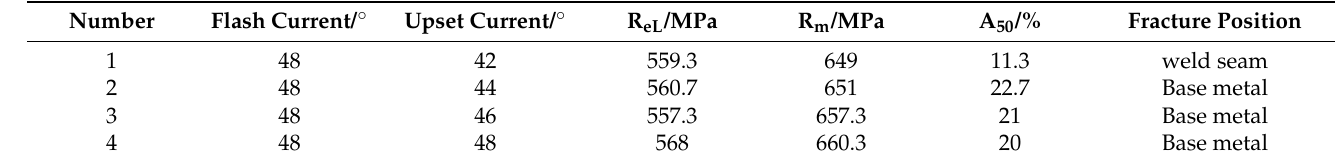
which is 284.9 HV. According to the results of joint hardness distribution under different upsetting currents, the optimal value of the upsetting current was determined as 44 ◦ . Table 2. The result of the tensile test of the joint under different upset current.